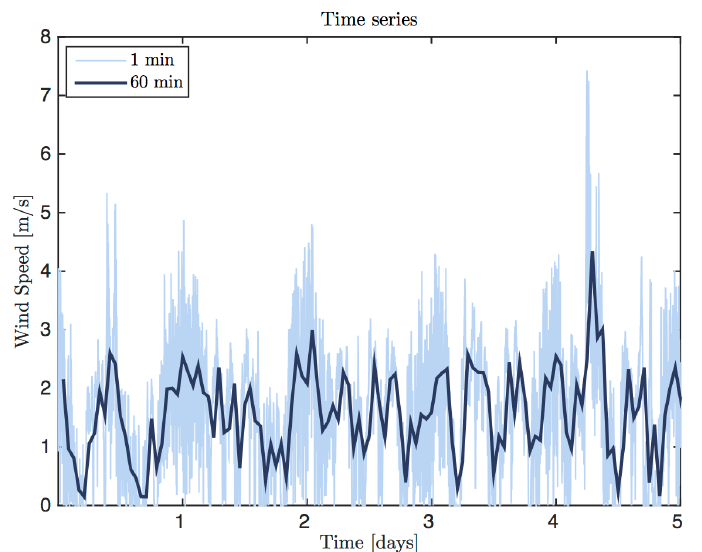
Figure 7. Time series of 1- and 60-min mean times in light and dark blue, respectively. A larger amount of information is observed in the 1-min time series; for example, the maxima values in the 1-min time series are not observed in the 60-min series. These differences produce underestimations in resource